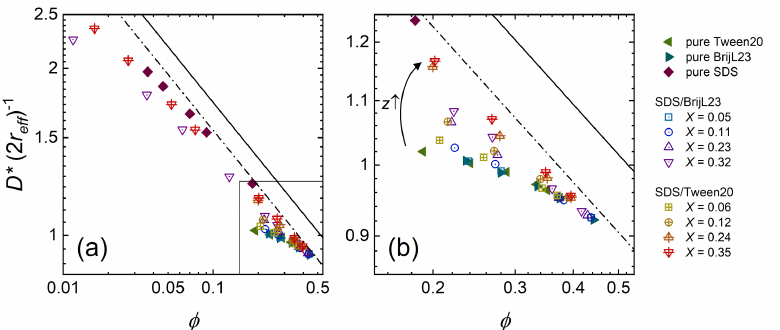
Figure 10. The mean intermicellar distance D * normalised to the effective micelle diameter (2 r eff ) in dependency of the volume fraction φ for all systems investigated. The lines are predictions according to Equation (8) with a pre-factor of f =1.436 (dashed line) and f =1.612 (solid line). Panel (b) is a magnification of the box in panel ( a ). The arrow in panel ( b ) highlights the influence of a higher surface charge z